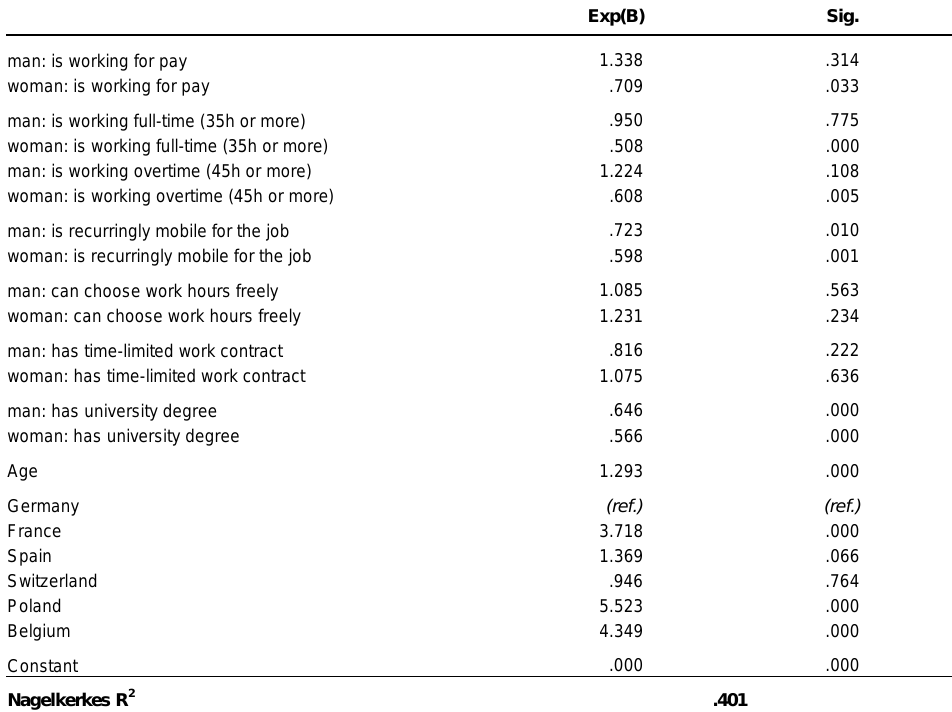
Table 1 : Circumstances fostering couples’ family foundation (logistic regression)